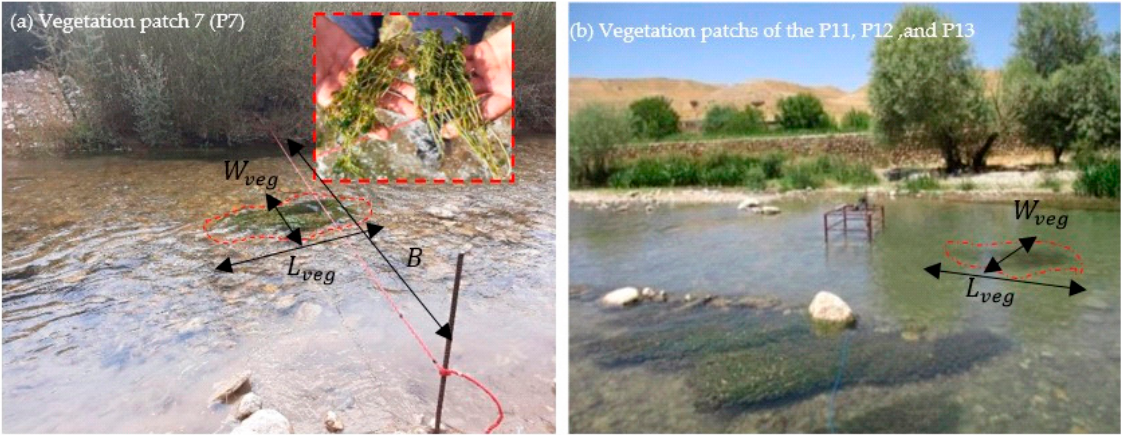
Figure 2. ( a ) Vegetation patch (P7) in one of the selected reaches of the Padena Marbor River. ( b ) Vegetation patches of P11, P12, and P13 in Beheshtabad Vegetation patches of P11, P12, and P13 in Beheshtabad River.